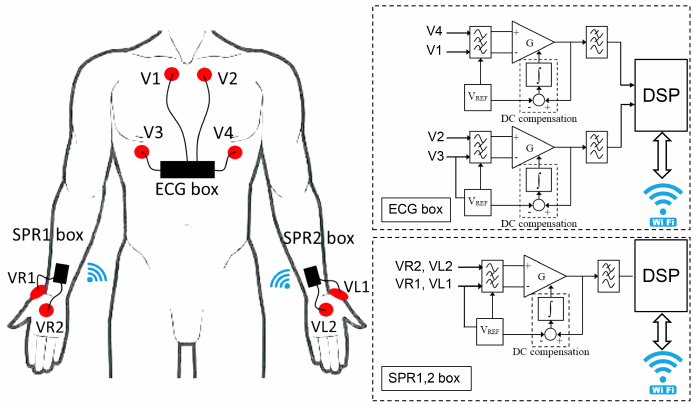
Figure 2. Electrode positioning and sensor block